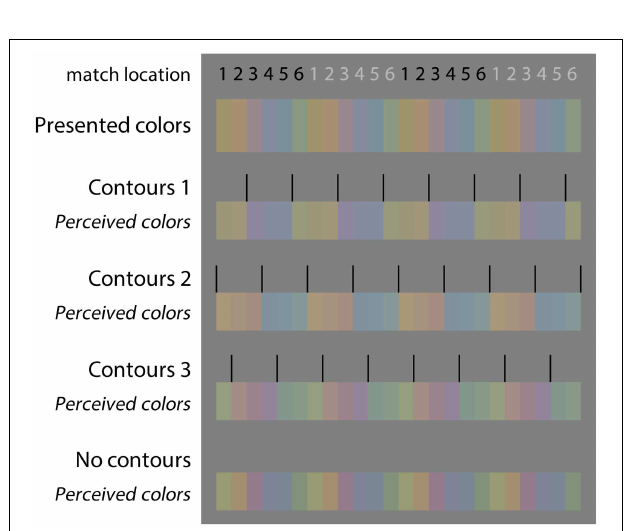
FIGURE 6 | Color matching results. For each of the images of Figure 5 , the presented color, the positioning of the outlines (relative to the spot where the color was to be matched), and the mean matching result of five observers is indicated. The four panels below each other reflect the four images of Figure 5 from left to right. The small numbers on top of each panel indicate the respective matching location on the stimulus. For illustration purpose, the data are repeated four times (from left to right) to mimic the repetitive, alternating color percepts on the original images (note that colors seen on the reader’s monitor may differ slightly from those in our actual